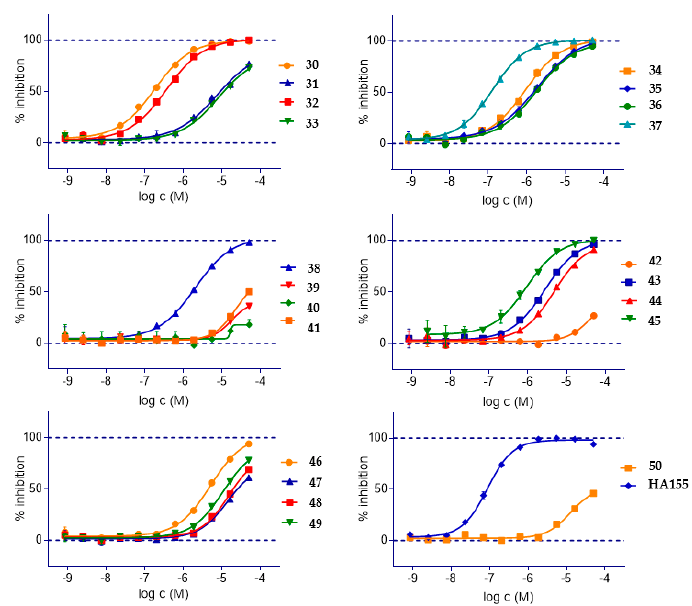
Figure 9. ATX inhibition results of biochemical testing of new benzoxaborole inhibitors. 11— concentrations dose–response curves, as average of duplicates, are